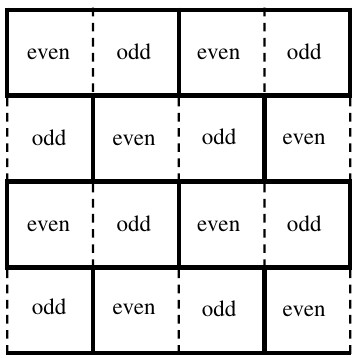
FIG. 5. The 2d square lattice after disentanglement. The qubits on dashed edges are removed from the system.